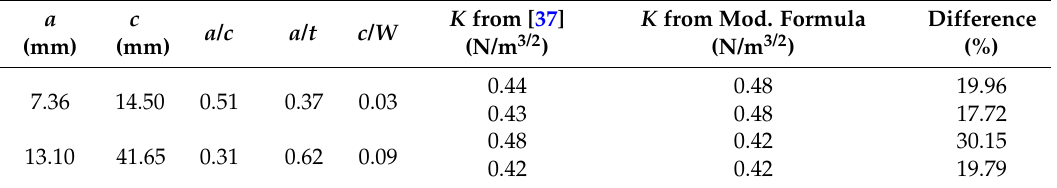
Table 2. Modified formulae vs. photo-elastic experiment data.